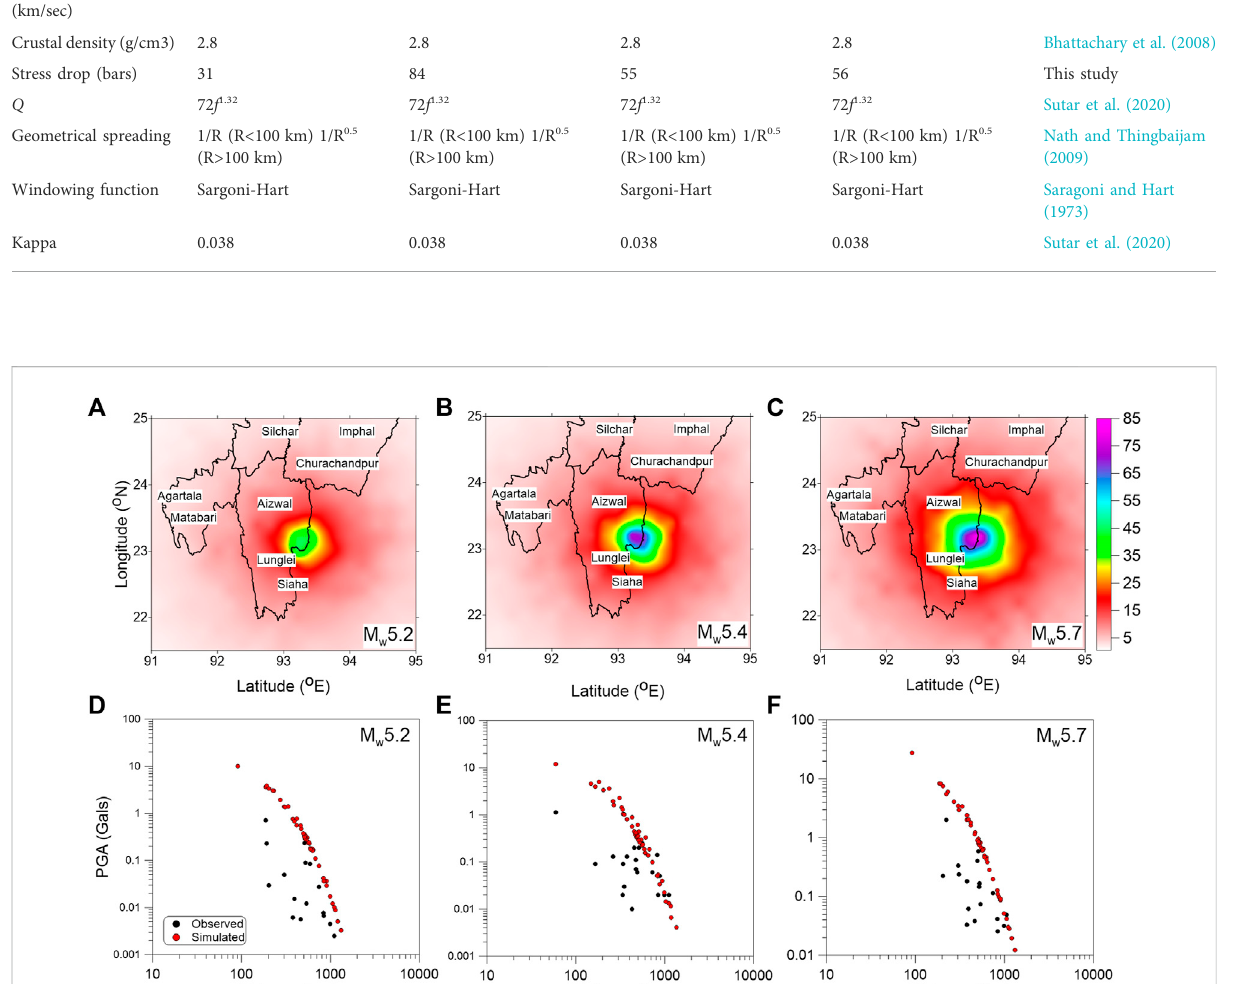
Frontiers in Earth